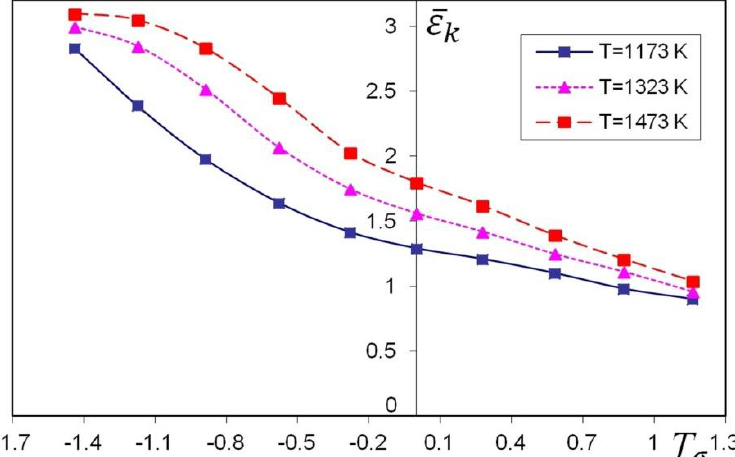
Figure 3. Relationship between the threshold effective strain and stress triaxiality and temperature for the X32CrMoV12-28 die steel.